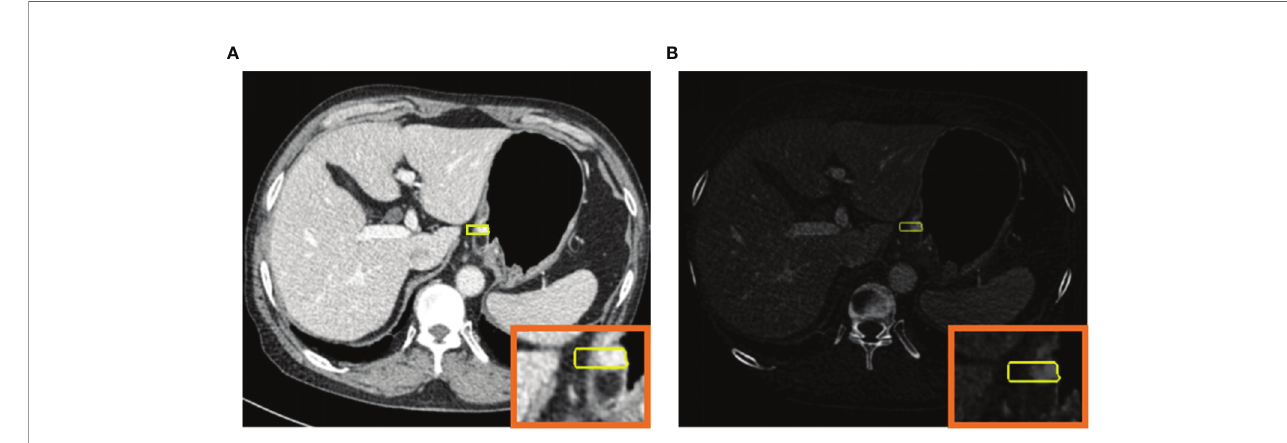
FIGURE 2 | 120-kV equivalent mixed image in the venous phase (A) and iodine map (B) for simultaneous